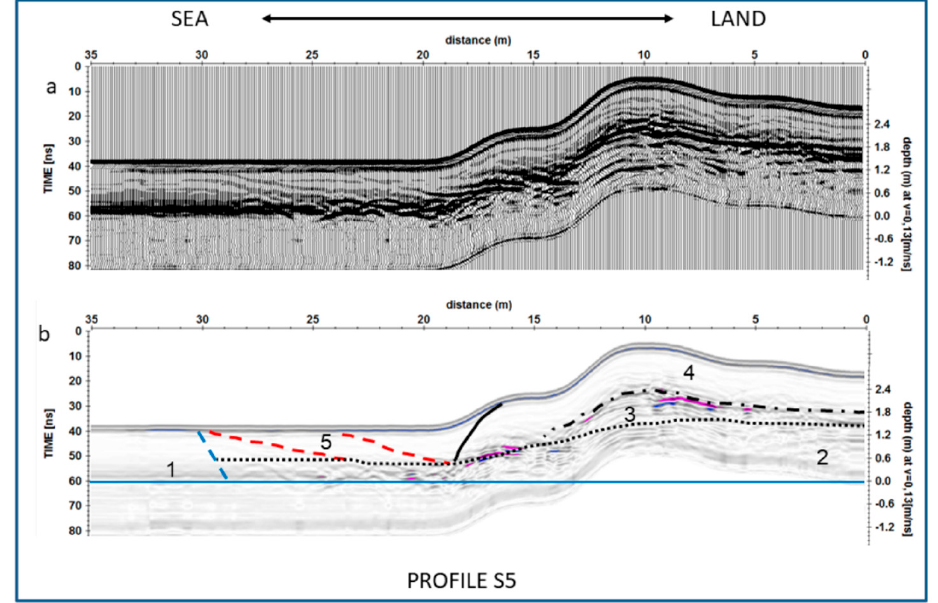
Figure 11. The GPR section (upper) carried out at Profile S5 (L’Arenile site) and its interpretation (lower). The section is shown in wiggle traces. Legend: 1—saturated zone; 2—bedrock (Pleistocene calcarenites); 3—soil; 4—sand ridge deposits; 5—storm wave berm. The blue dashed line divides the saturated from the unsaturated zone while the red dashed one outlines the landward-sloping lamination of a storm wave berm. The blue horizontal line is the position of mean sea level.